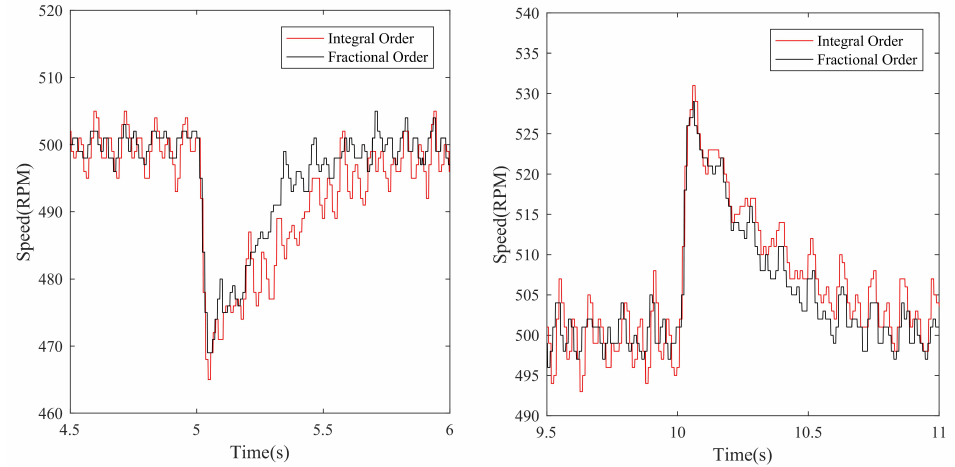
Figure 10. The speed curves with disturbance at middle speed.